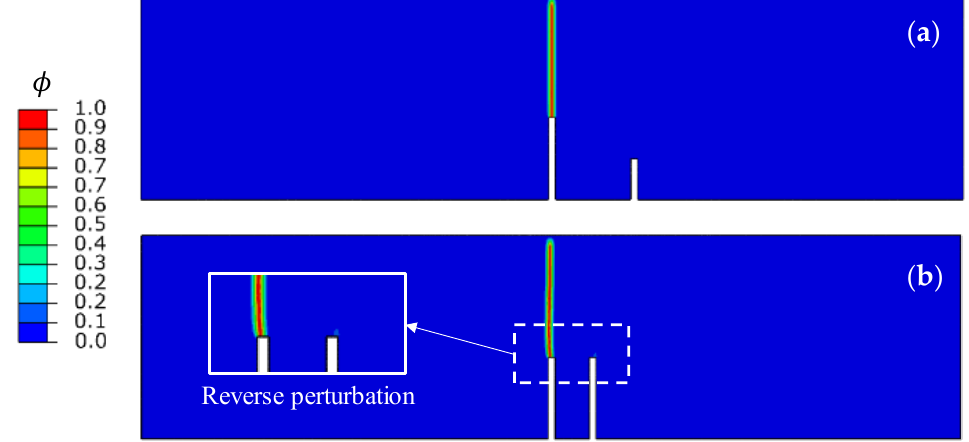
Figure 12. Predicted fracture features of double-notched concrete beams (( a ) a 0 = 60 mm, a 1 = 30 mm, d = 60 mm; ( b ) a 0 = 60 mm, a 1 = 60 mm, d = 30 mm).